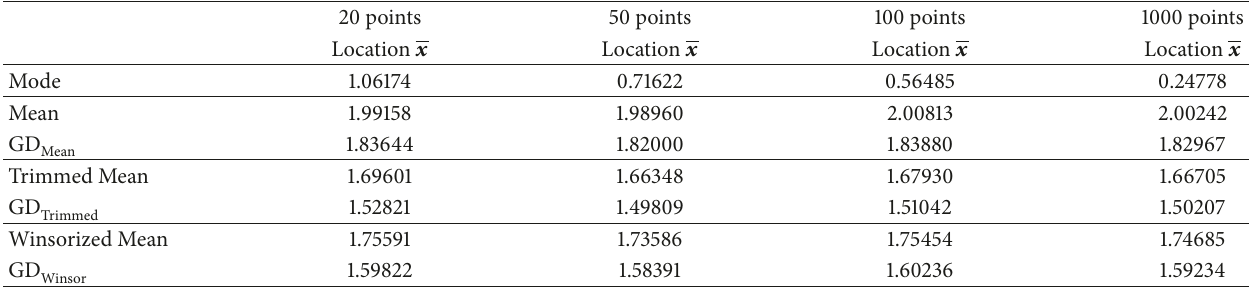
Table 34: Exponential distributions with 50% noise level.